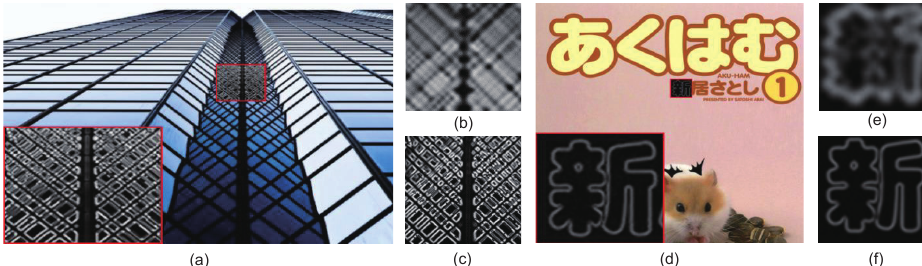
Figure 6. Results of gradient branch. Among them, ( a , d ) are the gradient maps of the reference HR images, ( b , e ) are the gradient maps of the corresponding LR images, and ( c , f ) are the gradient maps of the reconstructed images generated by the gradient branch.